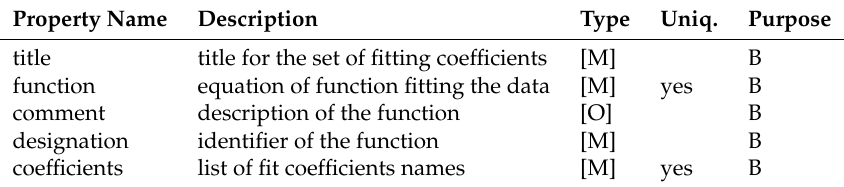
Table 5. List of properties/metadata for the object “Fitting coefficients”. The symbols [M] and [O] indicate that the metadata are either mandatory or optional in the import file. In the column “Uniq.”, we indicate whether the metadata define the uniqueness of the object. In the column “Purpose”, we indicate whether the information is meant for the BASECOL (B) public WebUI display and/or for VAMDC (V)